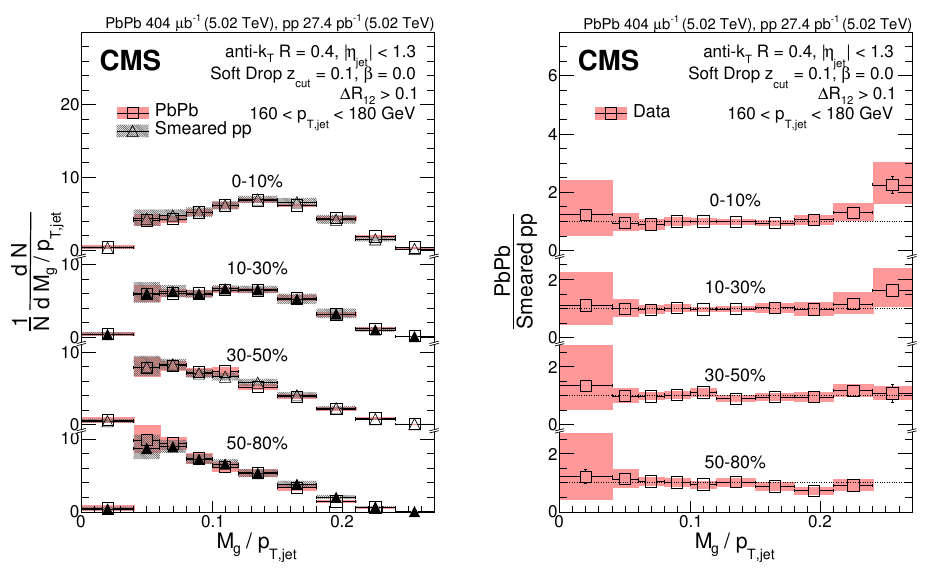
Figure 3 . (left) The centrality dependence of M g =p jet for the (0 : 1 ; 0 : 0) SD setting. Results are compared to the smeared pp spectra. (right) The ratio of PbPb data over smeared pp data. The heights of the vertical lines (colored boxes) indicate statistical (systematic) uncertainties. Statistical uncertainties are less than the marker sizes in most bins.